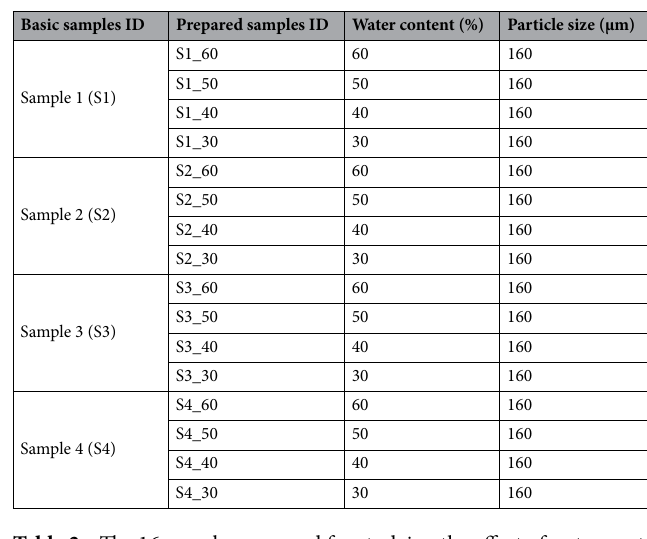
Table 2. The 16 samples prepared for studying the effect of water content.